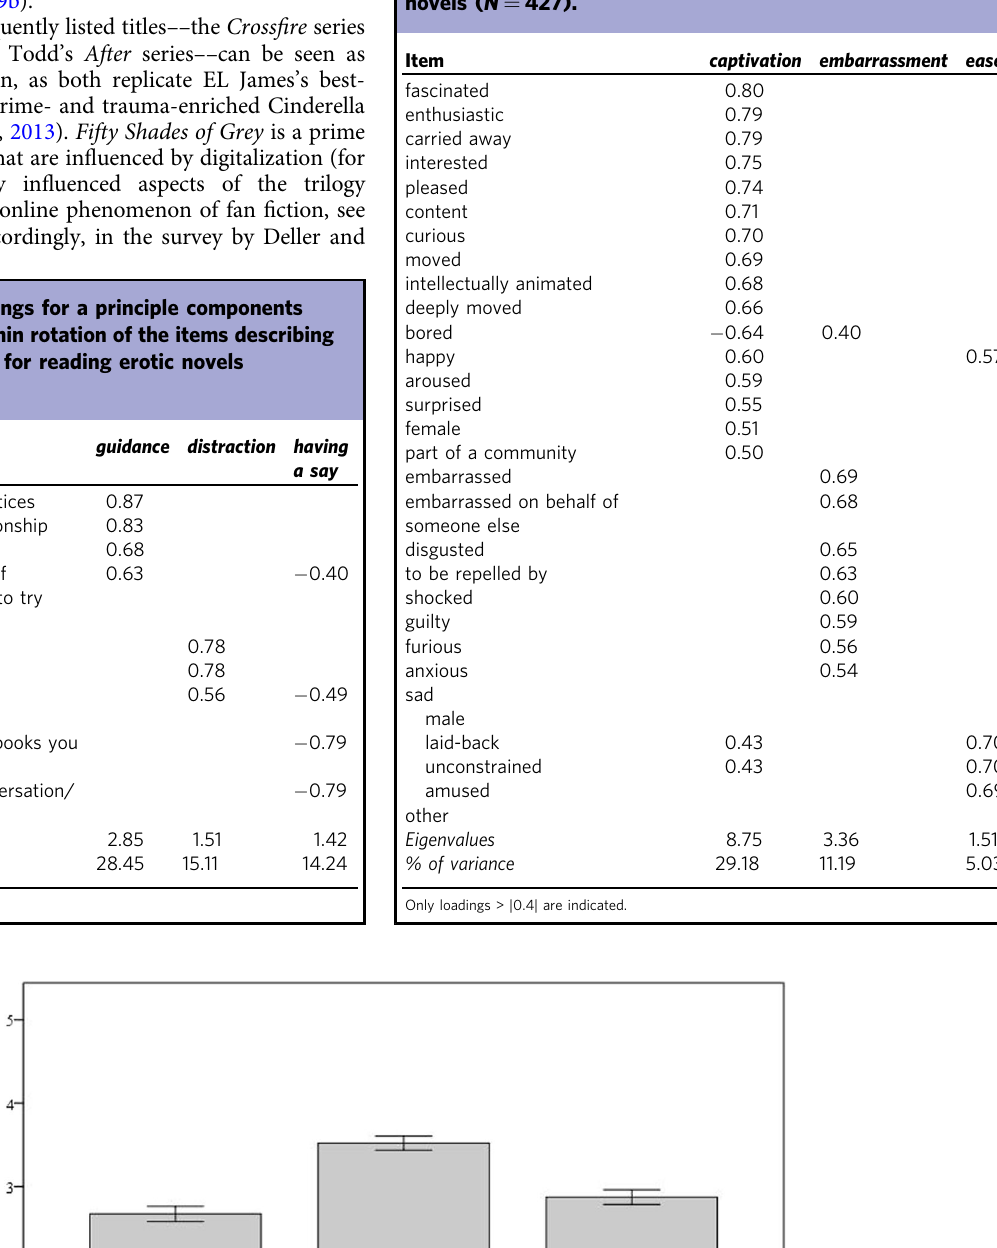
Table 6 Component loadings for a principle components analysis (PCA) with oblimin rotation of the items